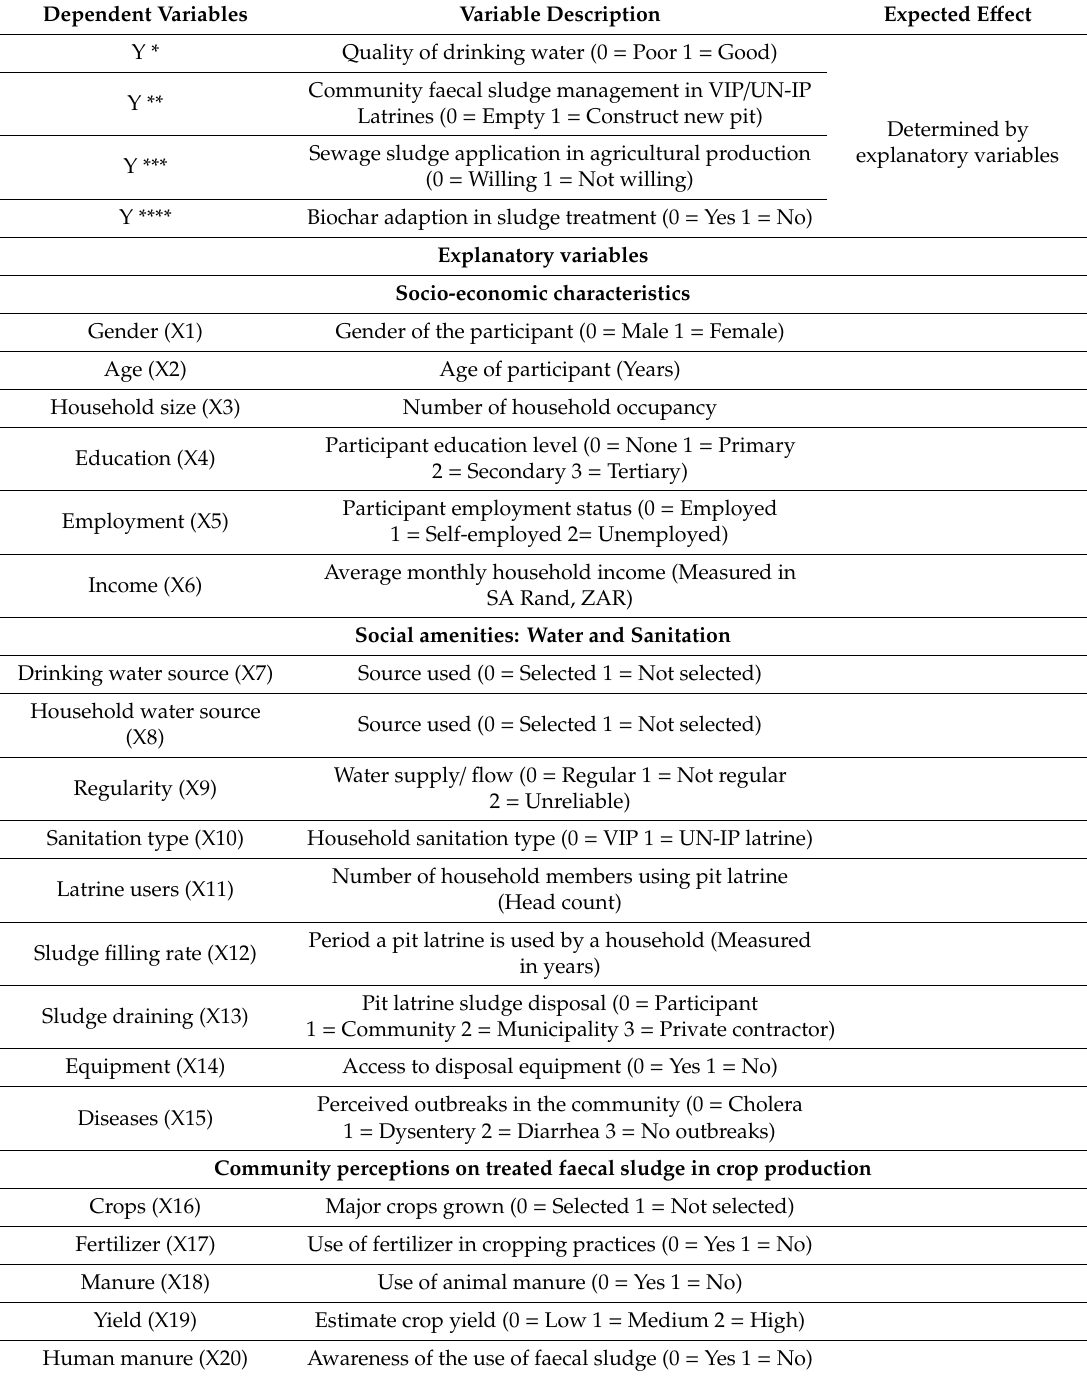
Table 1. Description and unit of variables used in the binomial logistic